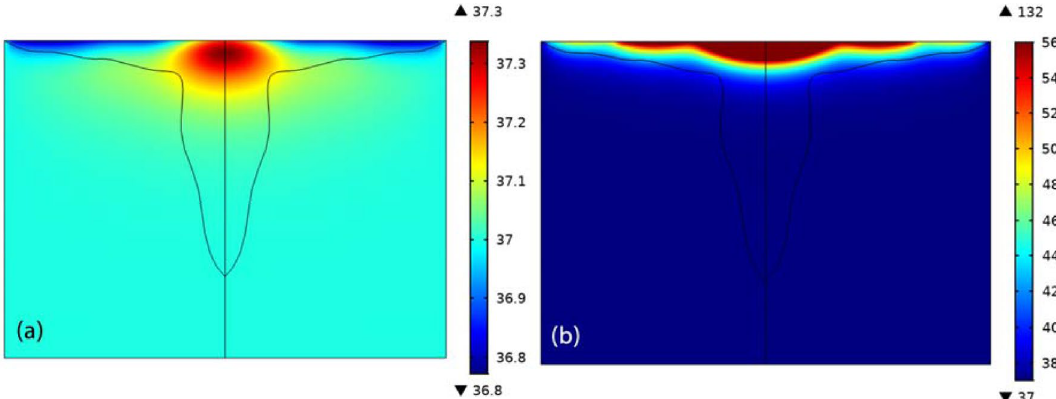
Figure 6. Temperature of the tissue after 10 min of laser irradiation in the absence (left) and presence (right) of